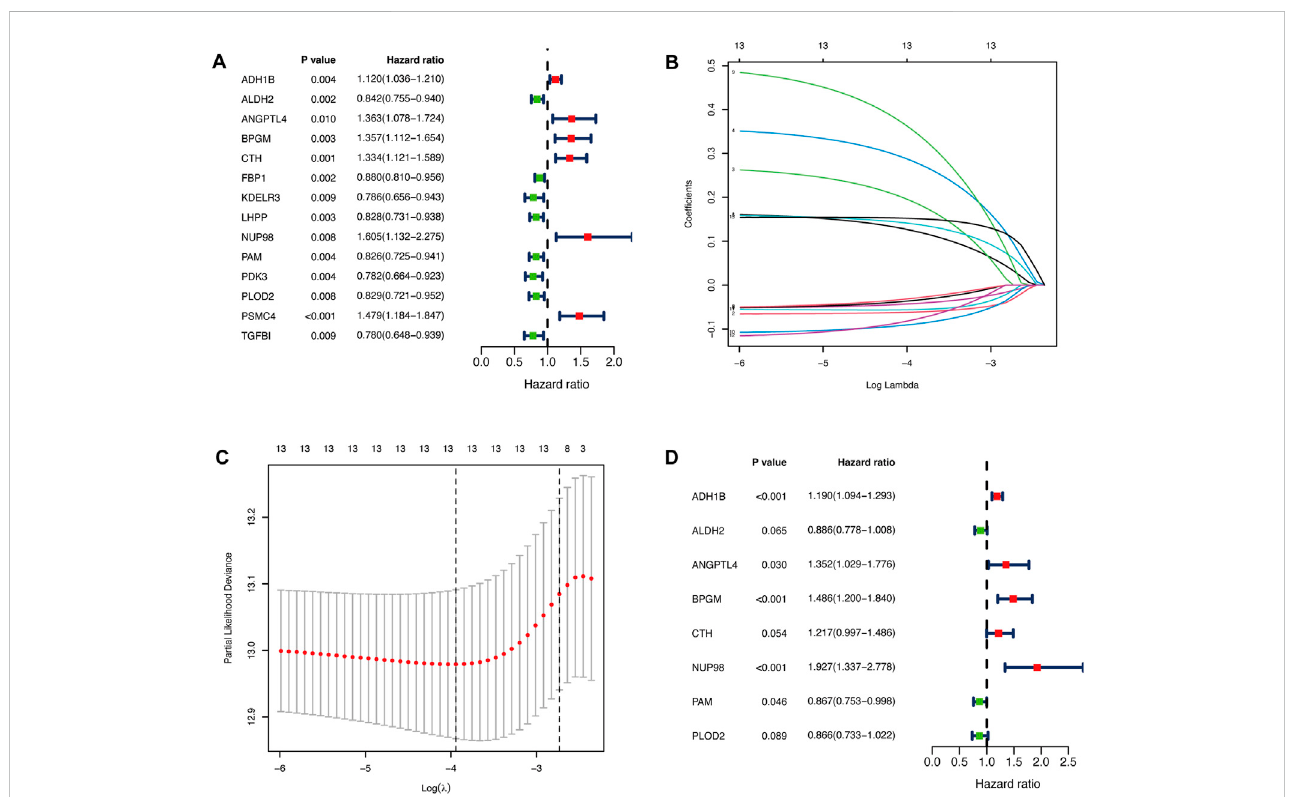
FIGURE 1 Identi fi cation of glycolysis-related prognostic genes in patients with DLBCL. (A) Fourteen glycolysis-related candidate genes were selected by univariate Cox regression ( p < 0.01). (B, C) Further selection of the optimal parameter (lambda) by LASSO Cox regression. (D) Establishment of the prognostic signature with 8 glycolysis-related genes based on multivariate Cox regression analysis. DLBCL, diffuse large B-cell lymphoma; LASSO, least absolute shrinkage and selection operator.